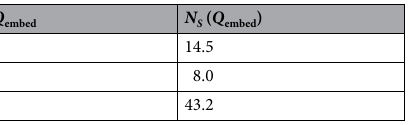
Table 3. Average number of embedded integer variables with Q embed components.